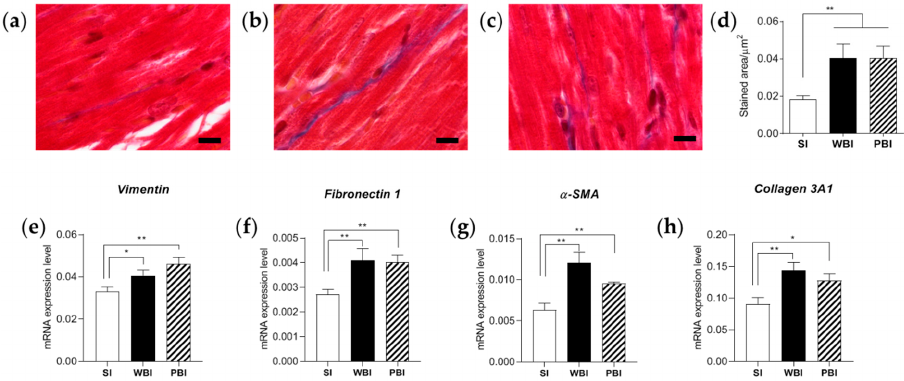
Figure 7. ( a – c ) Representative images of Masson’s trichrome staining of cardiac sections obtained from SI ( a ), WBI ( b ) and PBI ( c ) mice 6 months after exposure, in which collagen is stained blue. ( d ) Collagen-positive area quantified using HistoQuest 2.0.2.0249 software. Evaluation of vimentin ( e ), fibronectin 1 ( f ), α -SMA ( g ) and collagen 3A1 ( h ) expression levels, determined with qPCR analysis, 6 months after exposure. Each dataset represents the mean ± SEM of three independent biological replicates. * p < 0.05; ** p < 0.01 (Student’s t -test). Bars = 10 μ m.